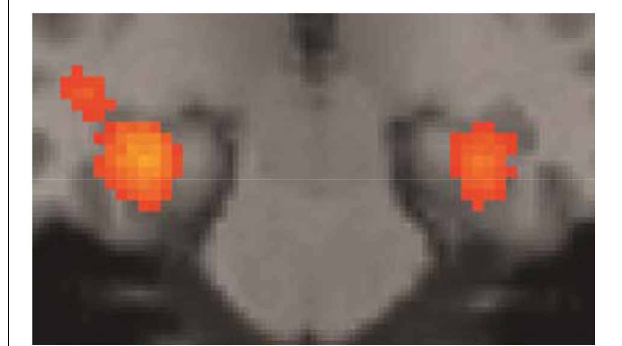
FIGURE 5 | Medial temporal lobe deactivations. Sensorimotor decision baseline vs. preference classification on day 5 (all clusters P FWE < 0 . 001). These effects were very similar on day 1.